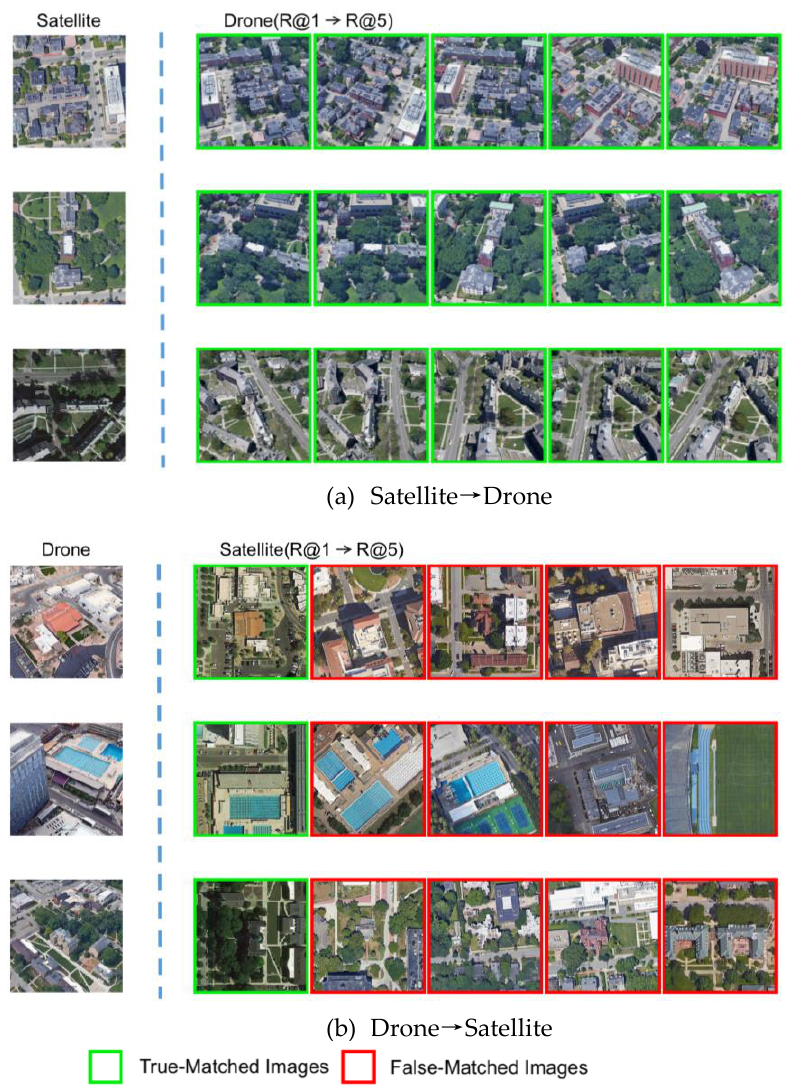
Figure 10. Visualized images retrieval results. ( a ) Top-5 retrieval results of Satellite → Drone. ( b ) Top-5 retrieval results of Drone → Satellite. True matches are in green boxes; false matches are displayed in red boxes.